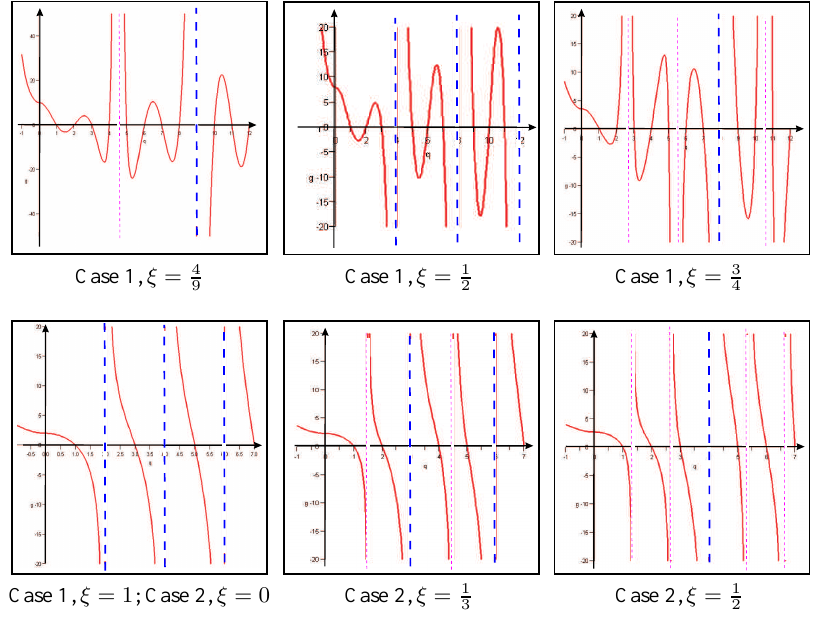
Figure 2. Functions (cid:13) 1 ( x=(cid:25) ; (cid:24) ) and (cid:13) 2 ( x=(cid:25) ; (cid:24) )